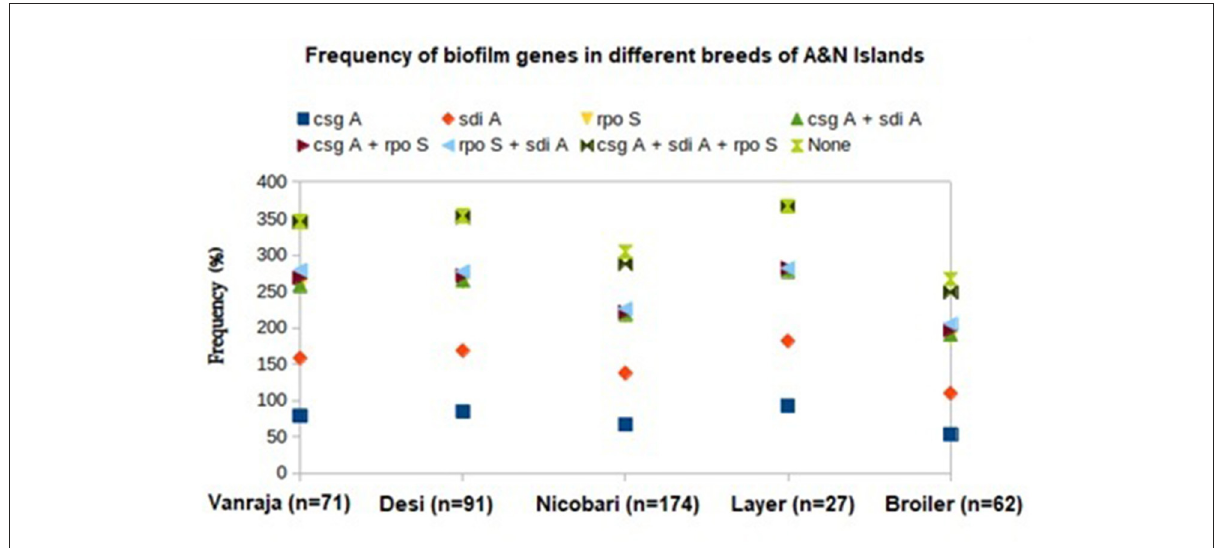
FIGURE3 Distribution of biofilm-associated genes in different birds reared in Andaman and Nicobar Islands (India).